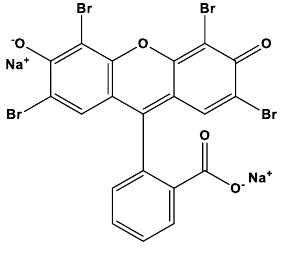
Figure 1. Chemical structure of the eosin Y dye.